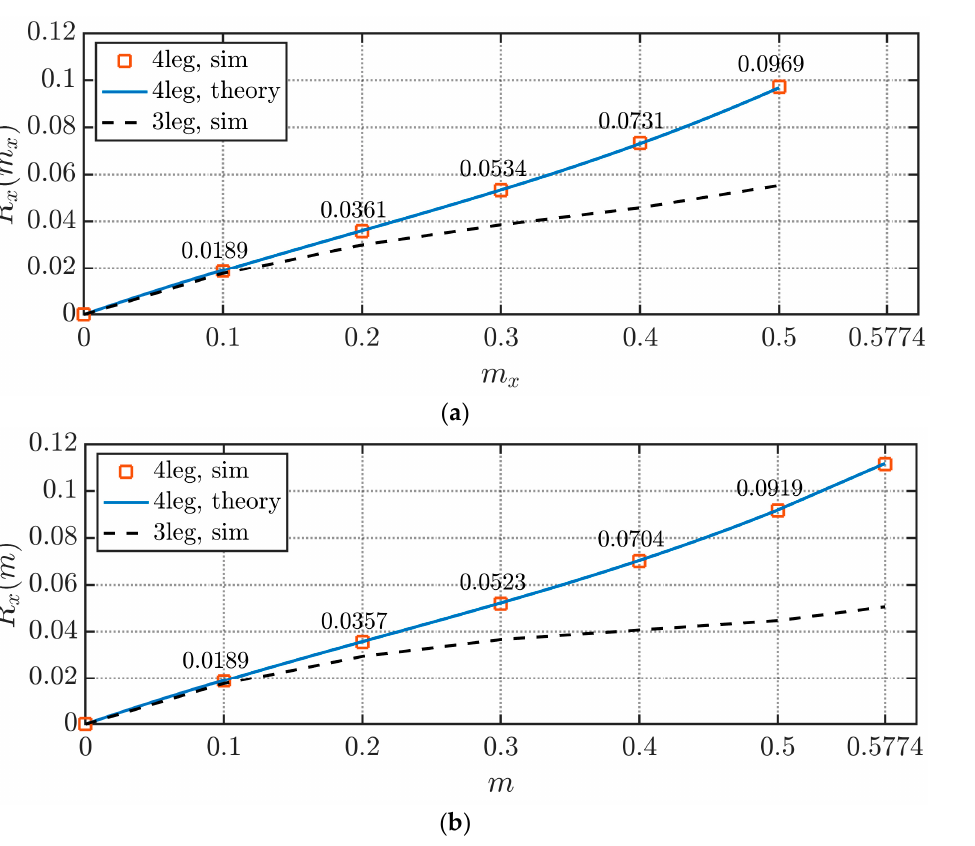
Figure 9. Normalized RMS value of phase current ripple in case of SPWM ( a ) and CPWM ( b ), also compared to three legs converter (dashed lines).